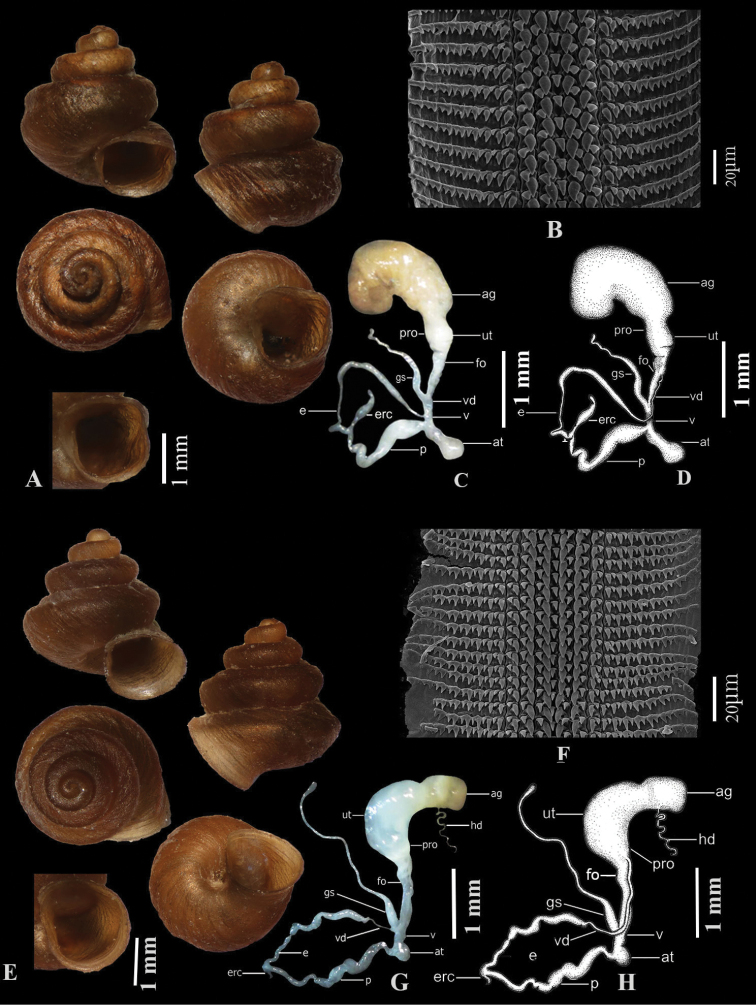
A–DAulacospira
tekavongae sp. nov. A holotype (ZRCBU 0610) B radula C, D genital system E–HAulacospira
vanwalleghemi sp. nov. E holotype (ZRCBUU 732) F radula G, H genital system.